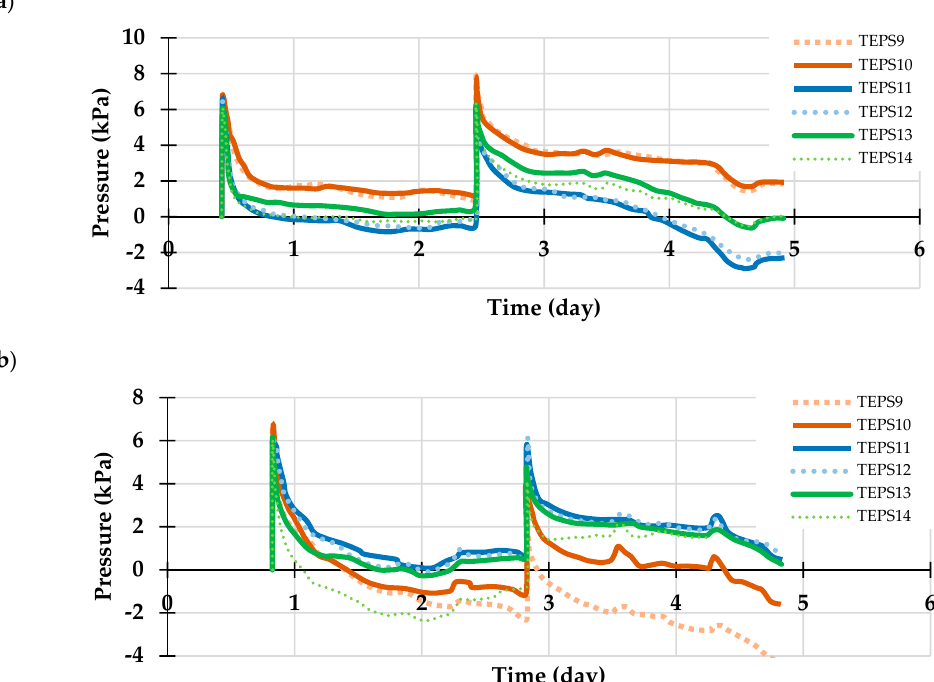
Figure 9. The pressure of the backfill on the barricade: ( a ) for the GSD #1 barricade, and ( b ) for the GSD #5 barricade.